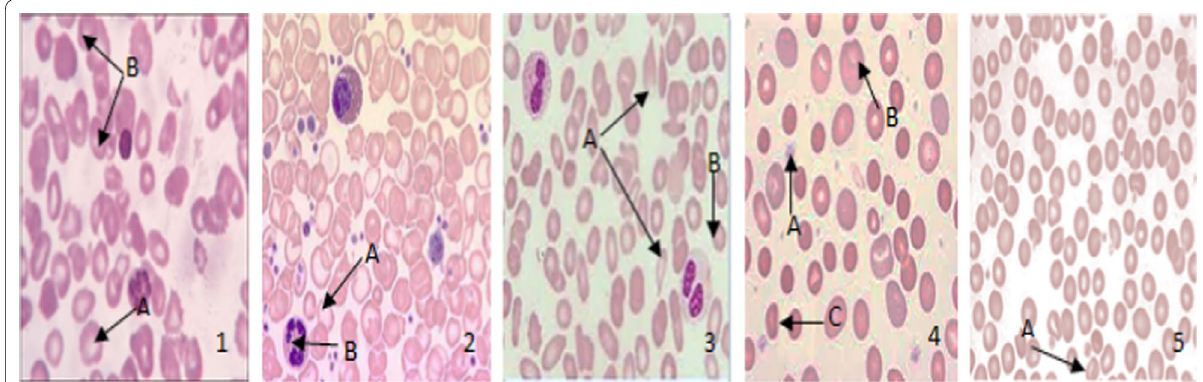
Fig. 8 Effect of n-hexane leaf extract of Ipomoea batatas L . on normochromic and normocytic cells. Phenylhydrazine alone A indicates macrocytes. B, hypochromic macrocytes and C platelet; (2) 5 mg/kg of ferrous (iii) hydroxide A indicates normochromic and normocytic cell, B multi-segmented neutrophil ; (3) 125 mg/kg n-hexane and phenylhydrazine, A, teardrop cell, B, normal red cell; (4) 250 mg/kg n-hexane and phenylhydrazine, A, platelet, B, partially hypochromic macrocytic red cell, C, poikilocytes and normocytic cells ( 5 ) 500 mg/kg n-hexane plant extract and phenylhydrazine, A, normochromic and normocytic cells. They were using haematoxylin–eosin dye with X 40